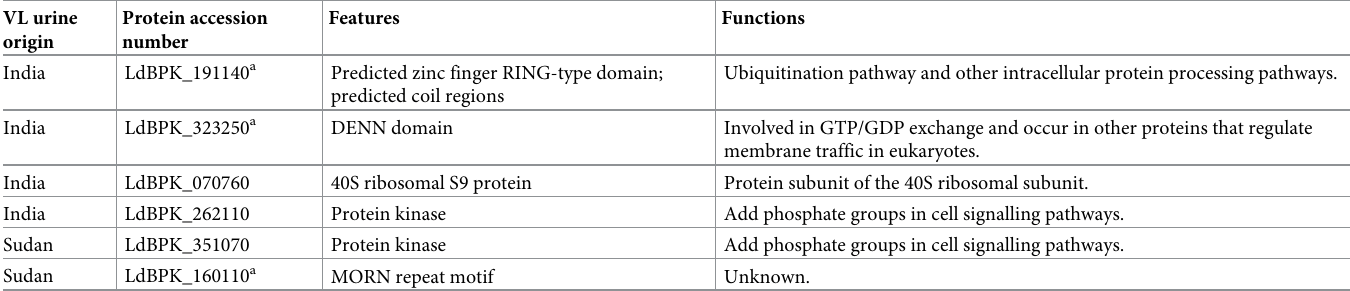
Table 2. Functions of Leishmania donovani proteins identified in urine of Indian and Sudanese patients with visceral